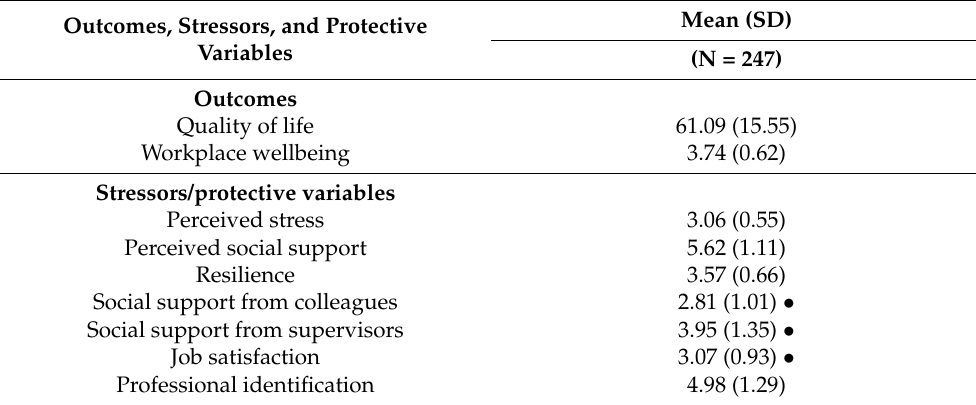
Table 2. Outcome, stressor, and protective variable